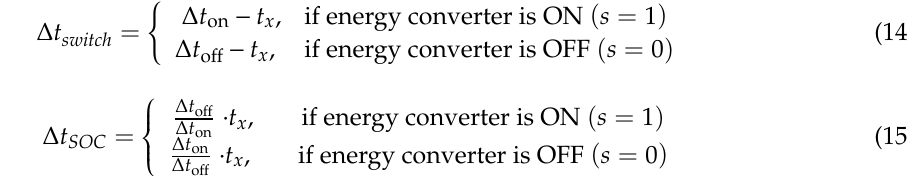
Figure 9. Two parameters can limit the holding time of the flexibility measure: The time interval ∆𝑡 (cid:2903)(cid:2899)(cid:2887) in which the limit of energy content of the storage is reached in flexible operation mode ( a ) or the time until the next switching time in reference mode is reached ∆𝑡 (cid:2929)(cid:2933)(cid:2919)(cid:2930)(cid:2913)(cid:2918) ( b ).